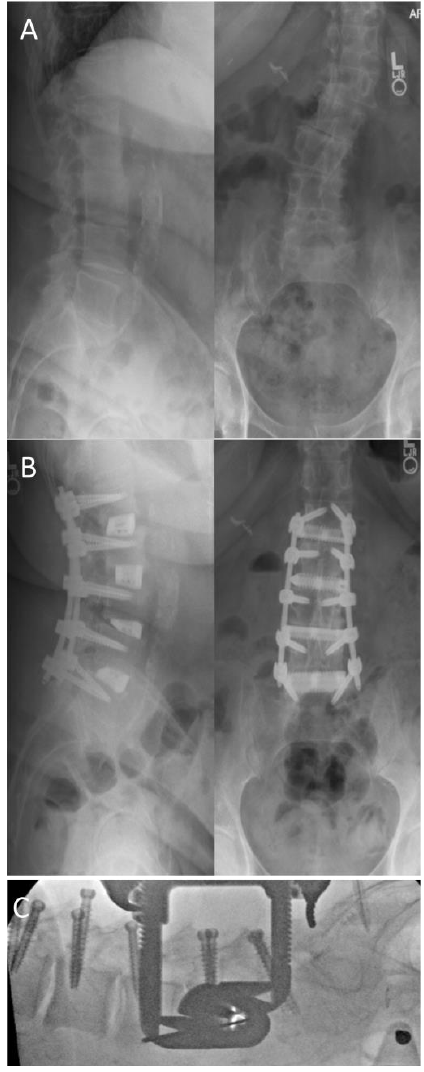
Figure 2. Case 2: ( A ) preoperative AP and lateral X-rays demonstrating sagittal and coronal imbalance; ( B ) postoperative AP and lateral images demonstrating posterior fixation and interbody cages as L1-L5 with correction of sagittal and coronal malalignment; ( C ) intraoperative lateral fluoroscopy demonstrating partial correction of lordosis following prone positioning.